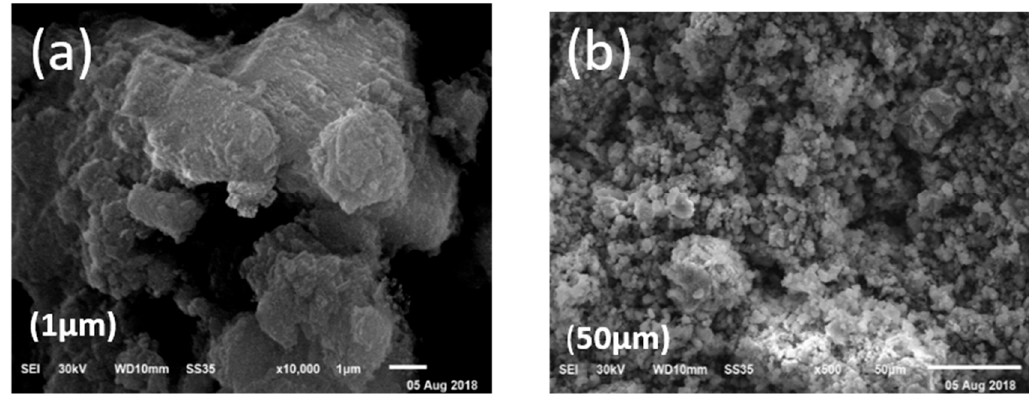
Figure 3. SEM images of Hap/CS nanocomposite: ( a ) 1-µm view; ( b ) 50-µm view.